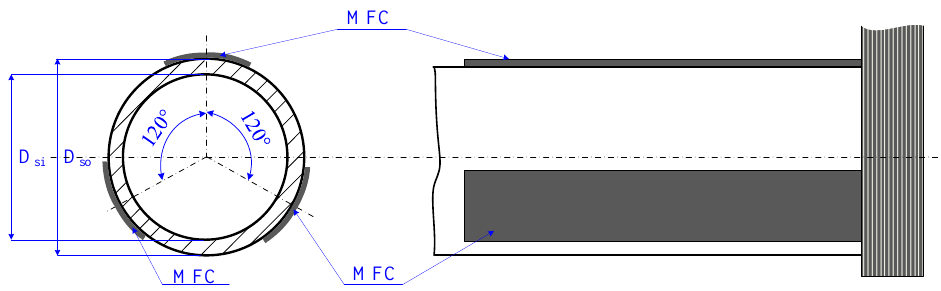
Figure 2. Displacement of MFC patches on shaft surface. The geometric and material properties of MFC patches are listed in Table 2. Geometric and material properties of MFC patches [24 – 26].